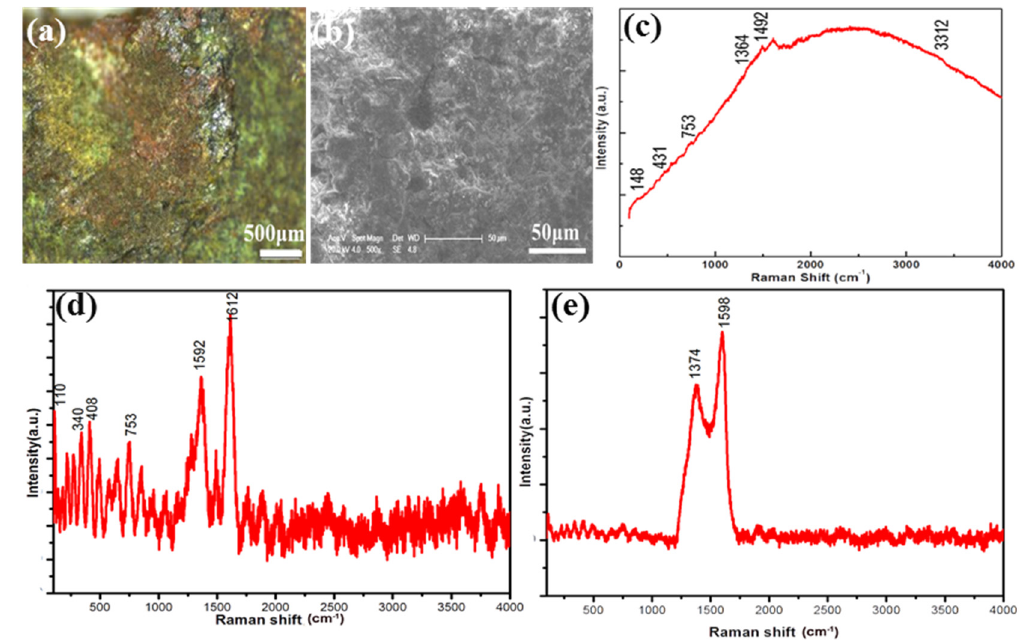
Figure 5. Characterizations of the corrosion products upon the bronze vessel ( Ding ) (Western Han Dynasty, collection No.: 1233): ( a ) Optical image; ( b ) SEM morphology; ( c ) Raman spectrum of malachite in a range 100–3500 cm − 1 ; ( d ) Raman spectrum of azurite in a range 100–3500cm − 1 ; ( e ) Raman spectrum of carbon in a range 100–2000 cm − 1 .